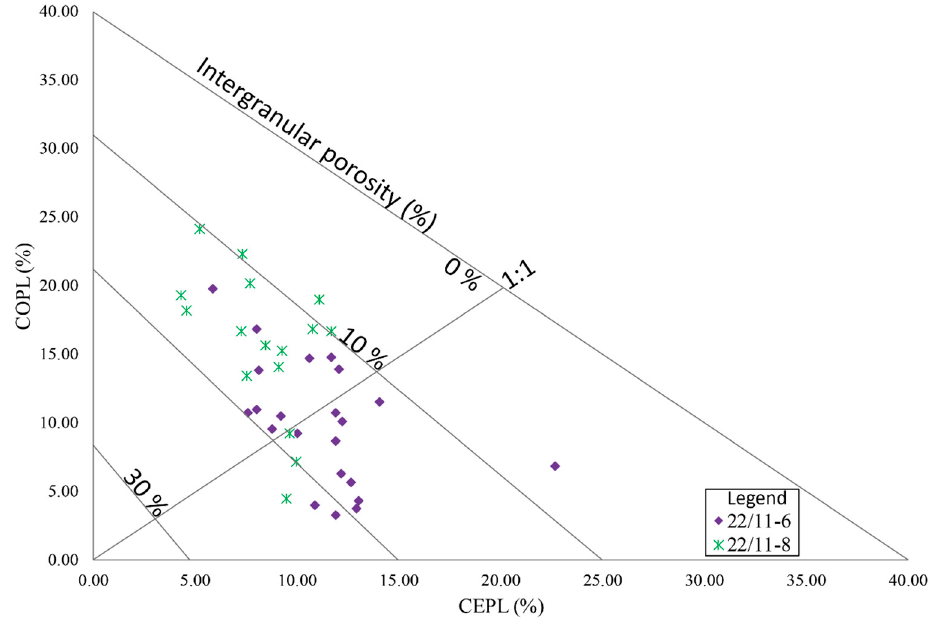
Figure 13. Plot of compactional porosity loss (COPL) against cementational porosity loss (CEPL) showing that porosity is mainly lost due to compaction than due to cementation.